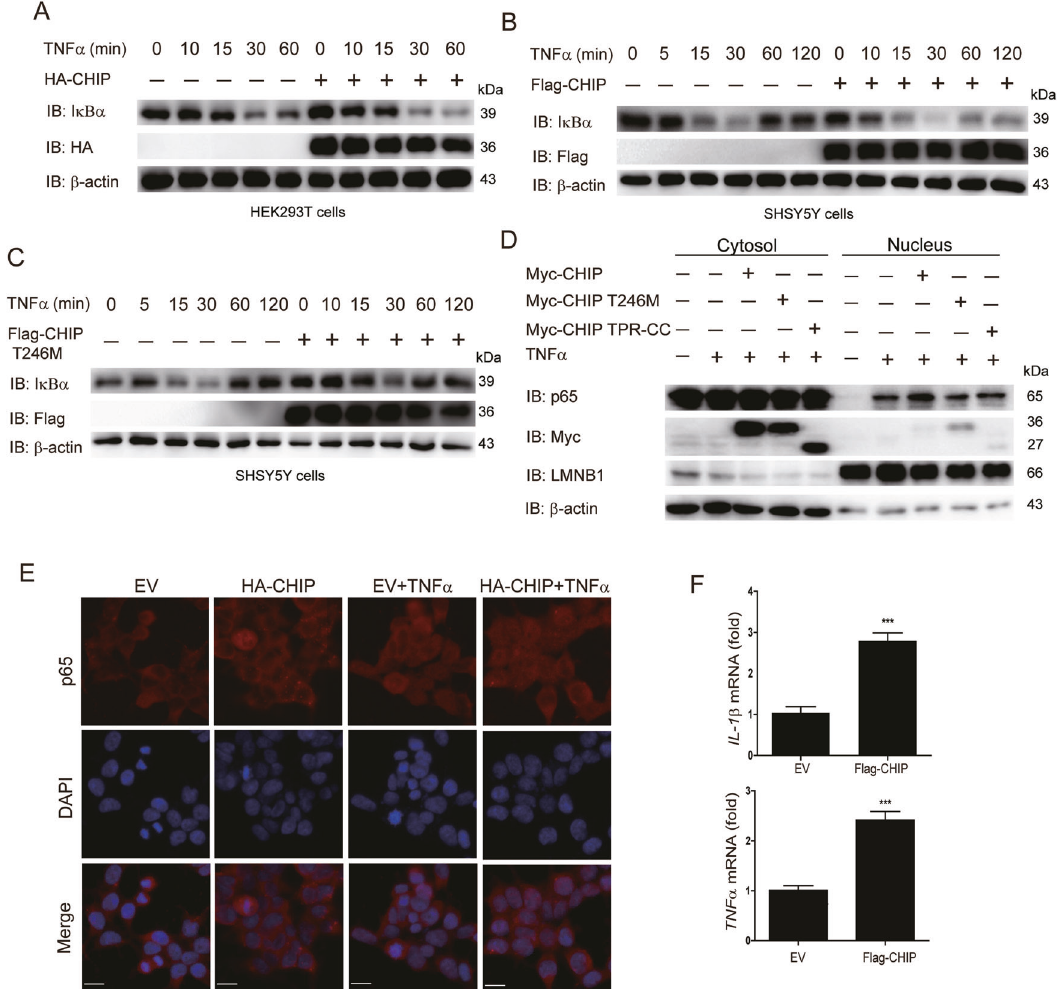
Fig. 1 CHIP promotes the activation of TNF α -induced NF- κ B signaling. A , B CHIP promoted the degradation of endogenous I κ B α . HEK293T cells ( A ) or SHSY5Y cells ( B ) were transfected with an empty vector, HA-CHIP, or Flag-CHIP, and stimulated with TNFa (5 ng/ml) for 0, 5, 10, 15, 30, 60, or 120 min. C CHIP (p.T246M) could not degrade I κ B α as CHIP. SHSY5Y cells were transfected with an empty vector or Flag-CHIP T246M, and stimulated with TNFa (5 ng/ml) for 0, 5, 15, 30, 60, or 120 min. D CHIP accelerated the nucleus translocation of p65. HEK293T cells were transfected with an empty vector, Myc-CHIP, Myc-CHIP T246M, or Myc-CHIP TPR-CC, and stimulated with TNFa (5 ng/ml) for 1 h. Western blot analyzed the endogenous p65 from cytosolic and nuclear fractions. E CHIP promoted the nuclear translocation of p65. HEK293T cells were transfected with an empty vector or HA-CHIP, and stimulated with TNFa (5 ng/ml) for 1 h, and then subjected to immuno fl uorescence analysis using a p65-speci fi c antibody. DNA was visualized with DAPI (blue). Scale bar: 20 μ m. F HEK293T cells were transfected with an empty vector or Flag-CHIP, and stimulated with TNFa (5 ng/ml) for 8 h. NF- κ B signaling target genes ( IL-1 β and TNF α ) expression detecting by quantitative real-time PCR. All results were representative of three independent experiments. The graphs showed the means ± SD of